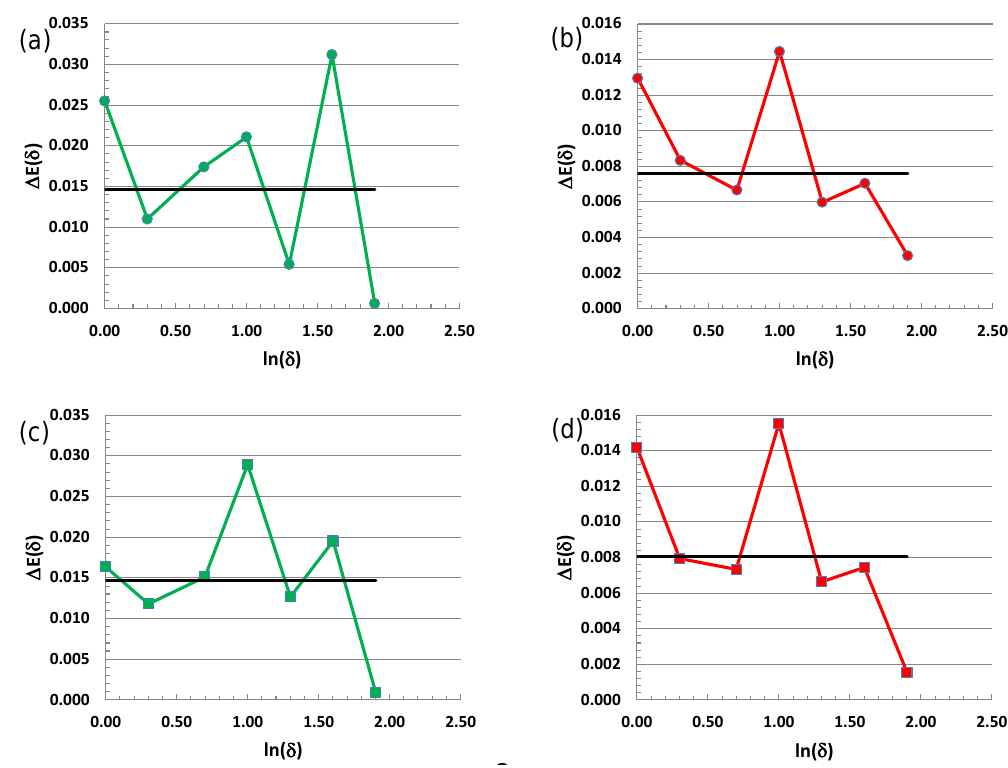
Figure 9. Increment of relative entropy ( (cid:49)E(δ)) with respect to the number of data points ( δ) of (a) grain nitrogen content (GN), (b) grain weight (GW), (c) wheat nitrogen content (PN) and (d) wheat weight (PW). Black lines represent (cid:49)E(δ) based on the entropy dimension ( D 1 ) of each